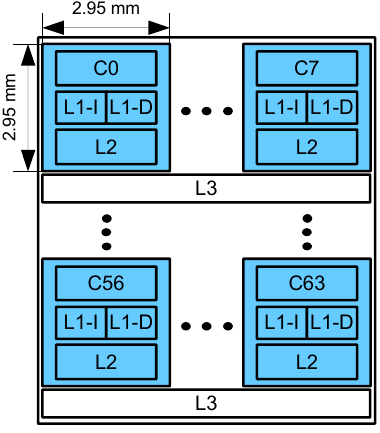
Figure 4. Floorplan of the simulated many-core system. Table 2. System configuration.